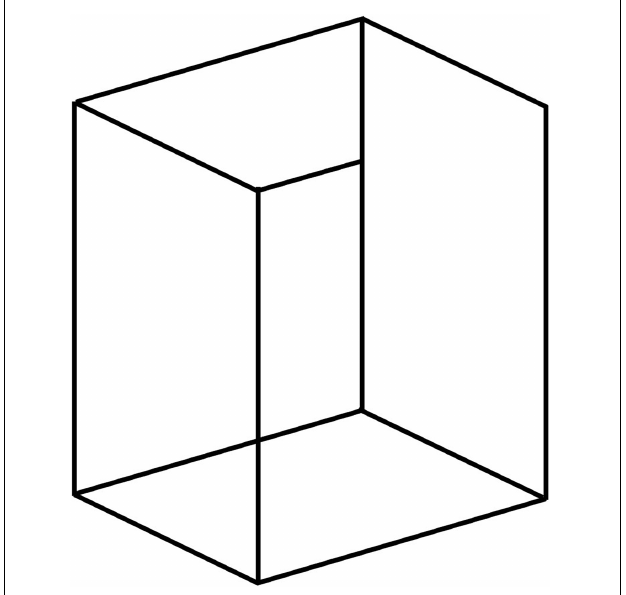
FIGURE 9 | Impossible object, from Hochberg (1981). The dominant interpretation is of an impossible configuration with an unfinished bar, even though a possible interpretation of a bottomless cube viewed from underneath is readily available; an illusion of ambiguity and paradox of visual